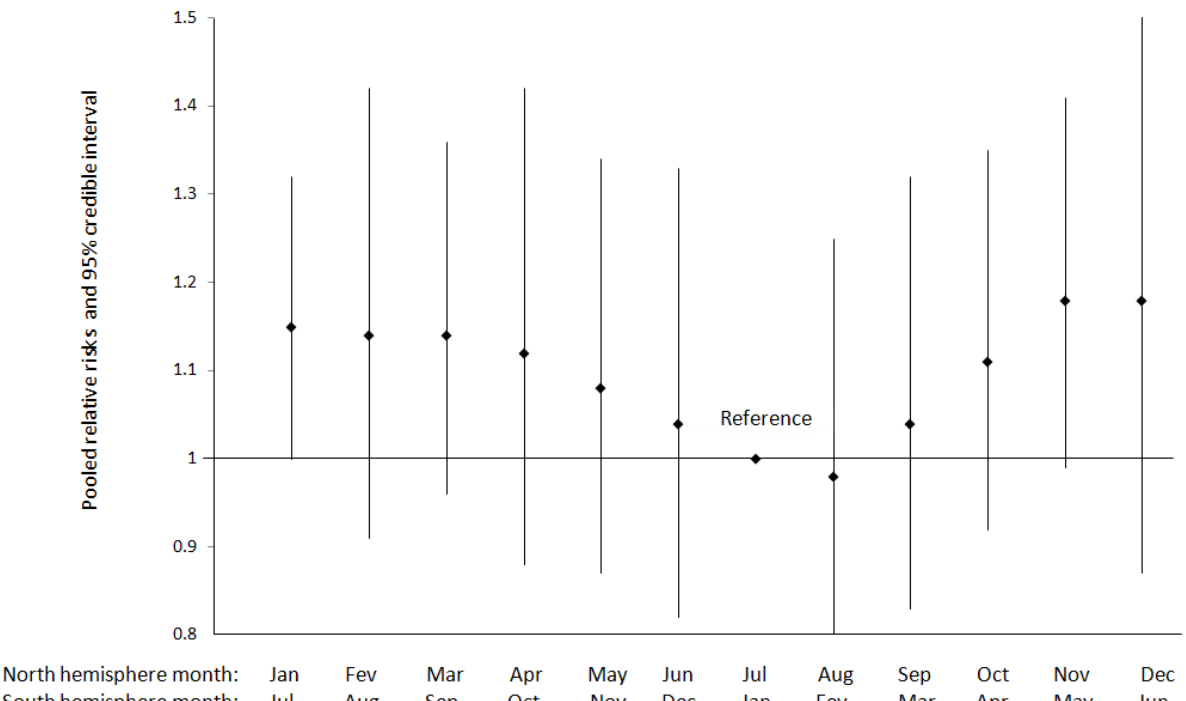
Figure 2. Pooled relative risks and 95% credible interval for the variation in preeclampsia incidence by month of birth ( N = 2,552,887